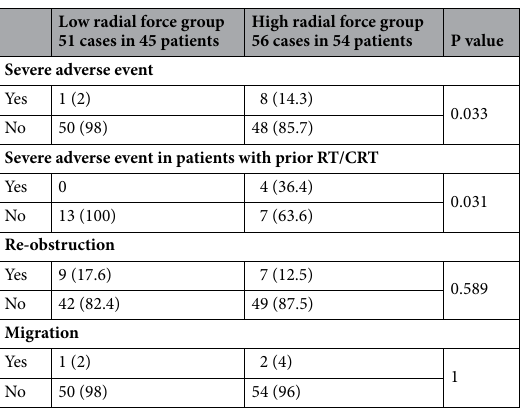
Table 2. Outcome of the two groups. Data are presented as n (%). These data were compared using Fisher’s exact test.